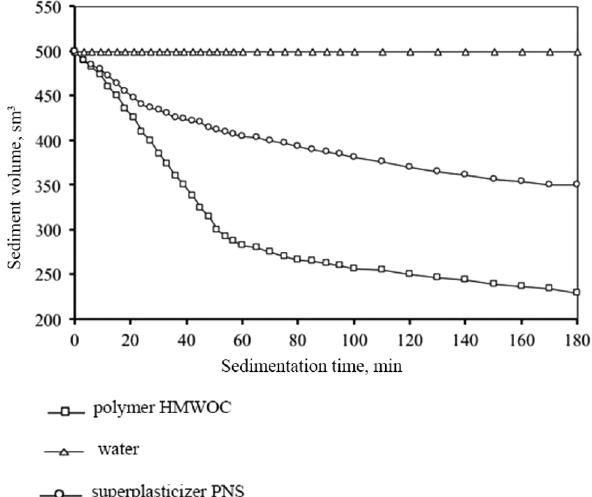
Figure 6: Di ff erential curves of dispersed phase particle distribution in